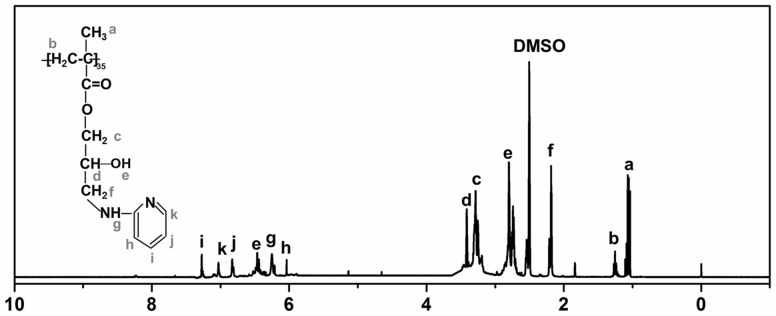

1H NMR spectrum of PGMA–APD (solvent: DMSO)